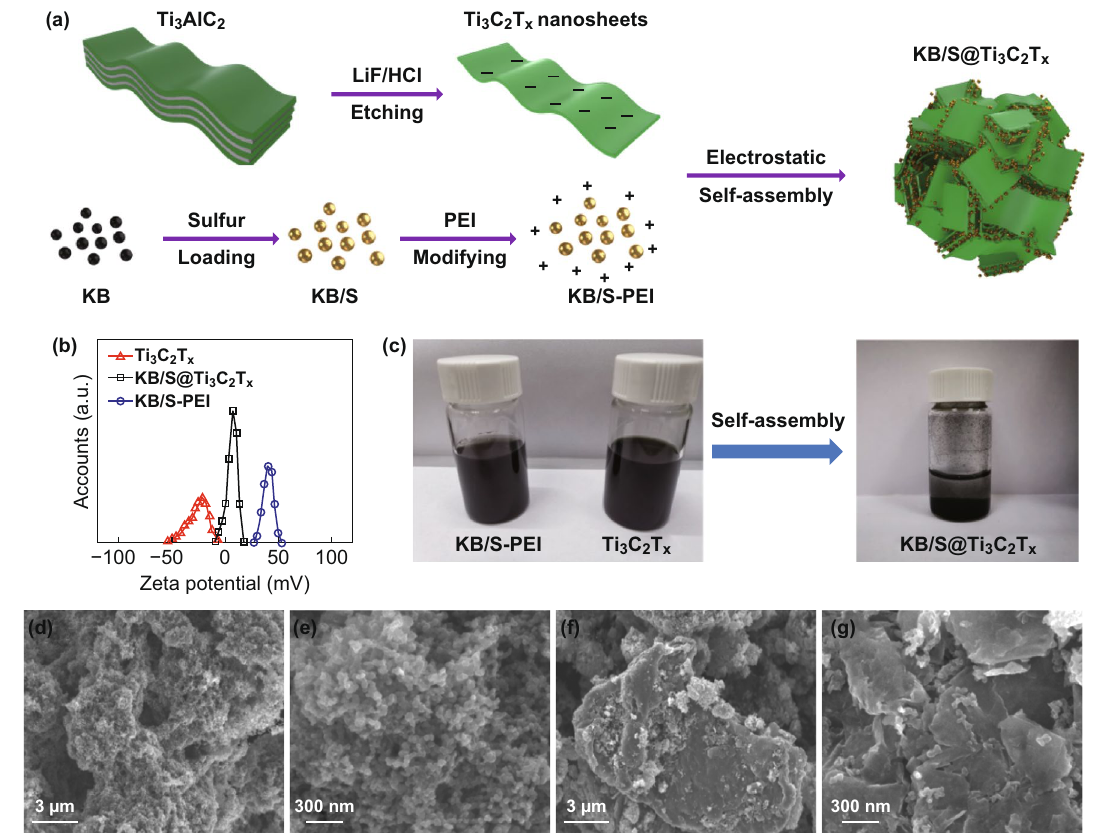
Fig. 1 a Schematic illustration of the fabrication of the KB/S@Ti 3 C 2 T x composite. b Zeta potential of Ti 3 C 2 T x nanosheets, KB/S-PEI and KB/S@Ti 3 C 2 T x . c Digital photographs of KB/S-PEI, Ti 3 C 2 T x , and KB/S@Ti 3 C 2 T x aqueous suspension. SEM images of KB/S ( d , e ) and KB/S@ Ti 3 C 2 T x ( f , g